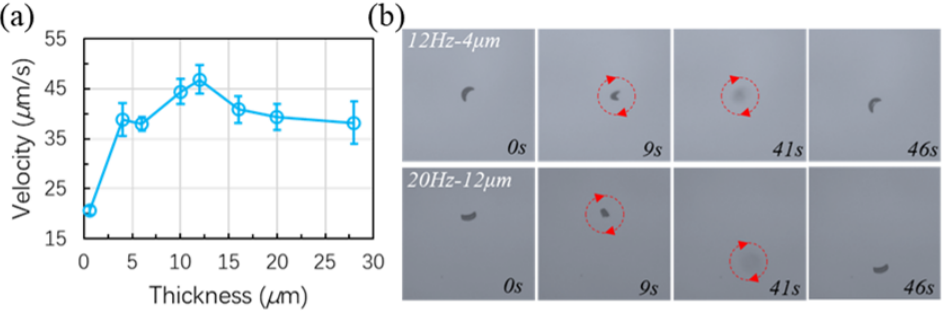
Figure 6. ( a ) Forward swimming velocity of the C1-type microswimmers with different thickness; ( b ) Out-of-plane (upward) motion of the C1-type microswimmers with different